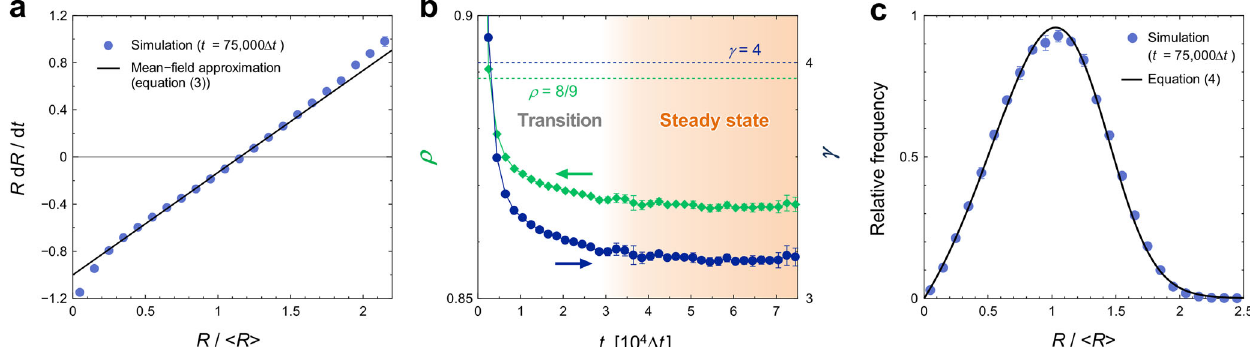
Fig. 3 Comparison of theoretical models and simulated results for the grain-size-related aspects of steady-state ideal grain growth. a Average growth rate for each size class. b Temporal variations of mean- fi eld parameters ρ and γ . c Grain size distribution. In all panels, numeric data points are given as the average of three replicated simulations for 2560 3 -point systems, with error bars representing the standard deviation. For most of the data points, the error bars are smaller than the symbols